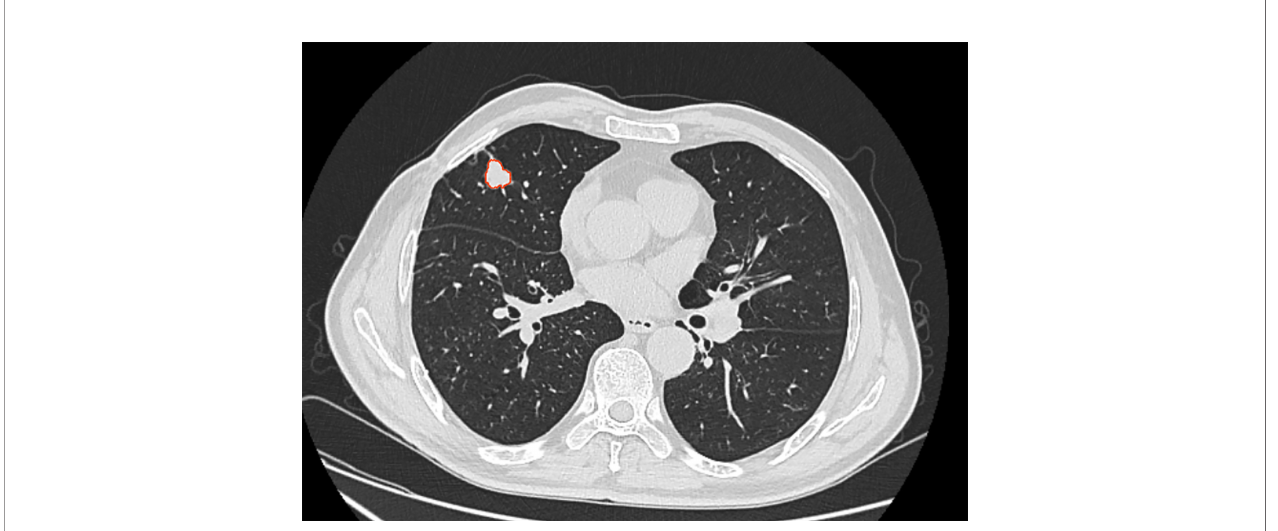
FIGURE 2 | 52 years-old patient, male, the lesion located in right middle lung. The area inside the red line represents the ROI for the